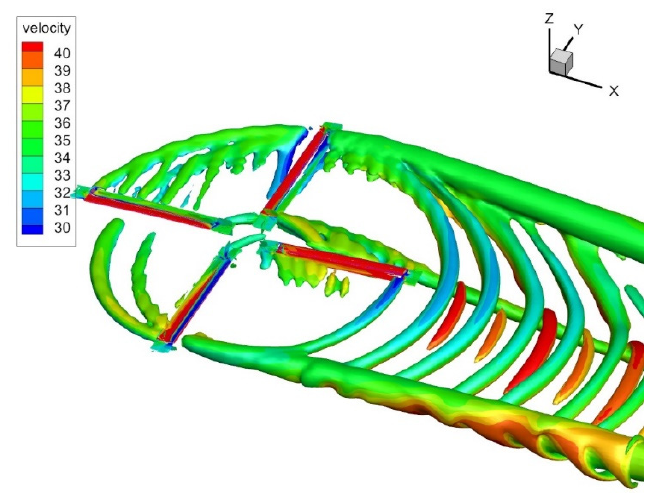
Figure 8. Sectional normal force at 87%R (mean removed and high-frequency content filtered): ( a ) original results; ( b ) error values of the results between the calculations in the present work and the experiment.